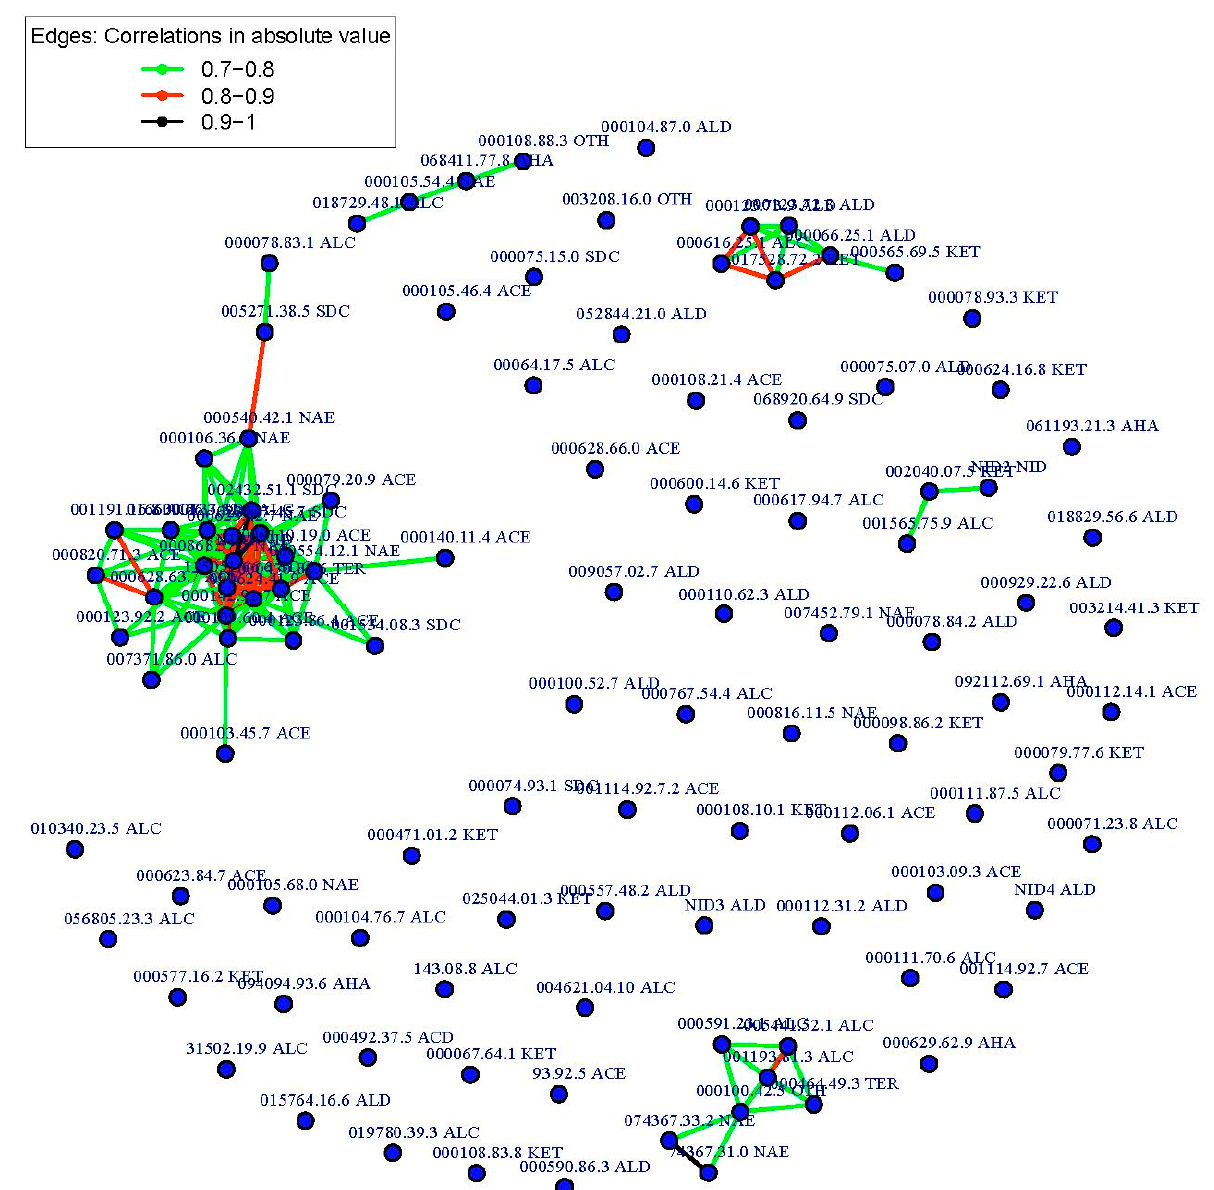
Figure 4. Correlation network analysis (CNA) based on absolute Pearson correlation coefficient with cut-off value greater than 0.7. Groups identified from individual volatile compounds analyzed for the Near-Isogenic Lines (NILs) with introgression on melon chromosome 3 (SC3-5-7, SC3-5-8, SC3-5-12, SC3-5-13, and SC3-5-14) and the parental control ´Piel de Sapo´ (PS). CAS numbers use dots instead of dashes. ACE, acetate esters; NAE, non-acetate esters; SDC, sulfur-derived compounds; ALD, aldehydes; KET, ketones; ALC, alcohols; TER, terpenes; AHA, aliphatic compounds; OTH, other compounds; NID, unidentified compound.